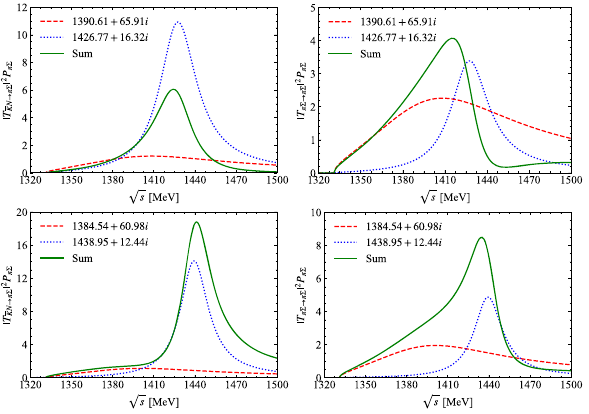
Fig. 6 The same as Fig. 5 but with Eqs. (22) and (23) for four coupled channels (upper) and two coupled channels (lower)